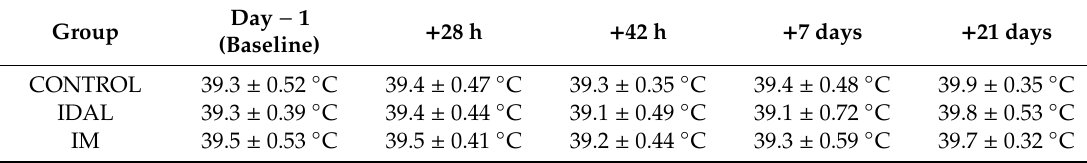
Table 7. Mean percentage of pigs from the CONTROL, IDAL, and IM groups showing a local reaction at the site of the injection + 28 h, + 42 h and 21 days post-vaccination. Group + 28 h + 42 h + 7 days + 21 days CONTROL 0 0 0 0 IDAL 18% 16% 11% 7% IM 1% 1% 1% 1% p -value between IDAL and IM < 0.0001 0.0001 0.012 0.10 Table 8. Mean rectal temperature of pigs from the CONTROL, IDAL and IM groups on day − 1, + 28 h, + 42 h, 7 days, 21 days post-vaccination.